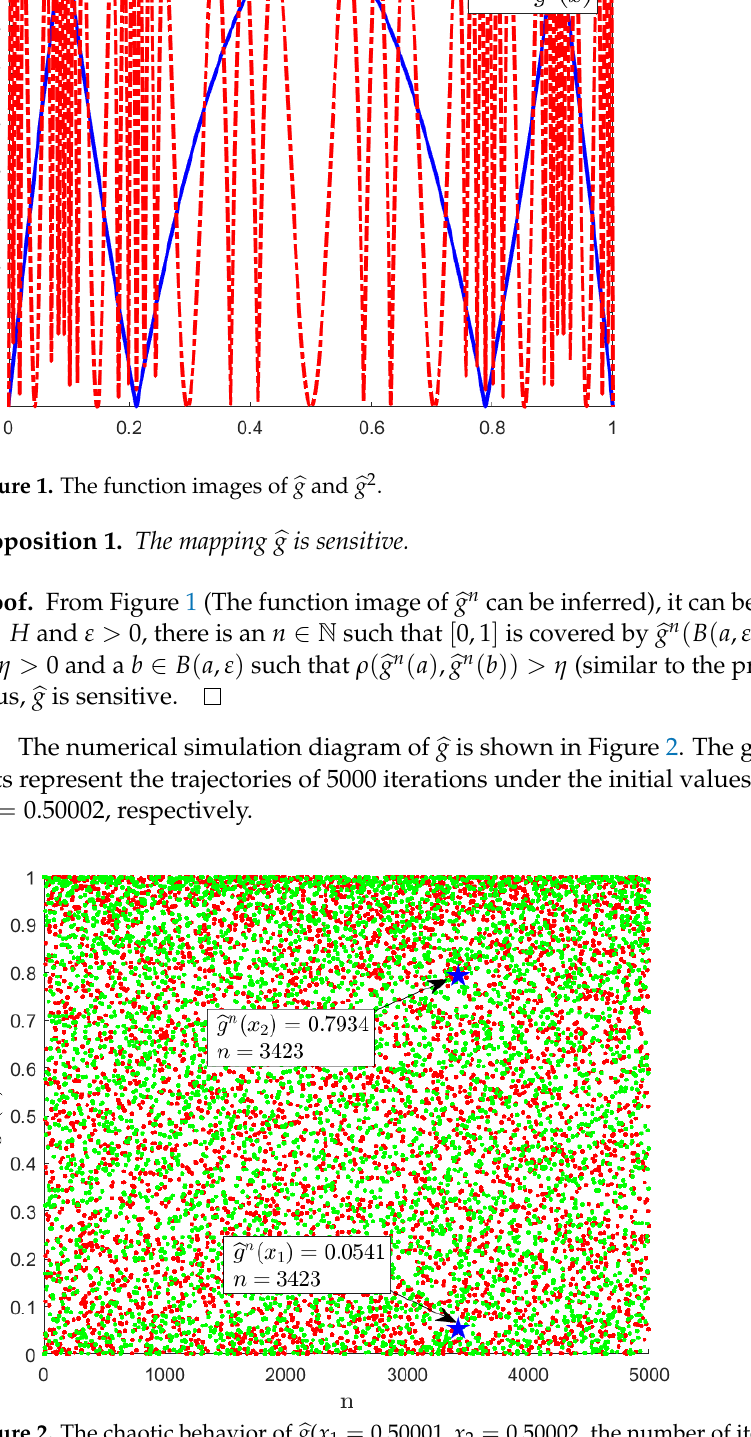
and disordered. ρ ( x 1 , x 2 ) = 0.00001, but ρ ( (cid:98) g ( x 1 ) , (cid:98) g ( x 2 )) = 0.7393. This means that